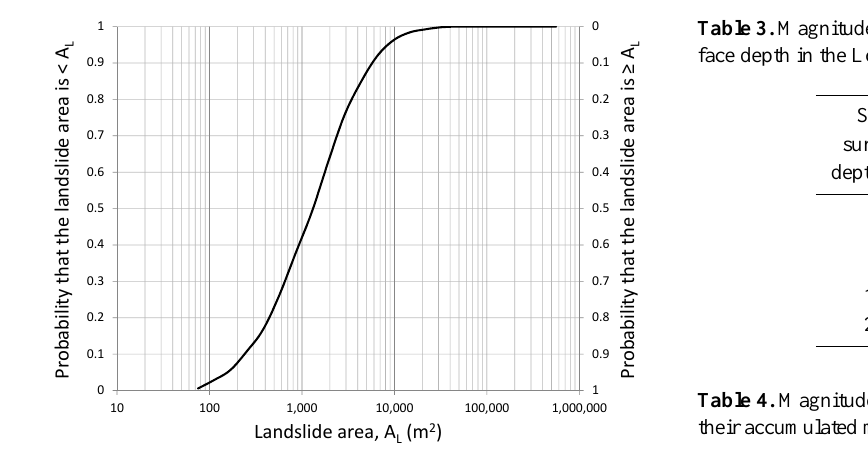
Figure 4. Probability of landslide area in the Loures municipality (based on the work done by Guillard and Zêzere, 2012).